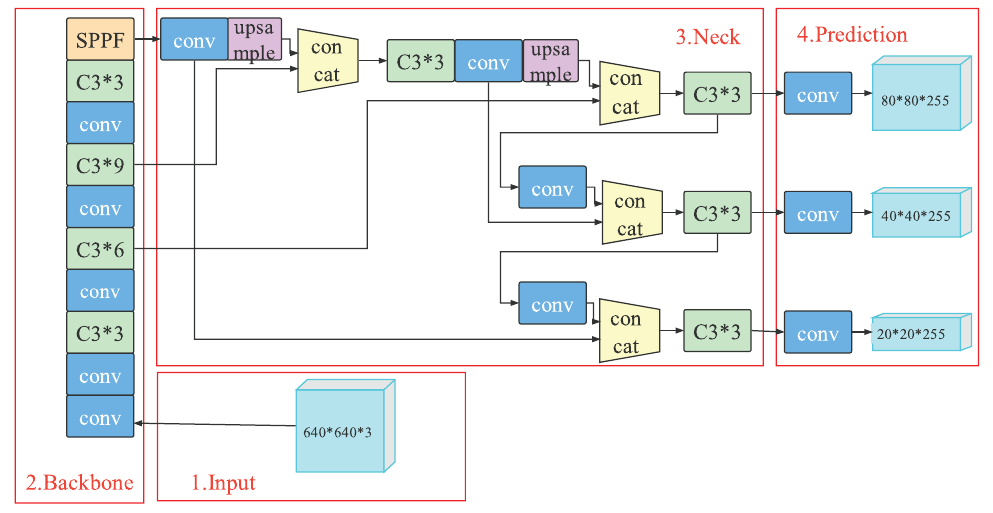
Figure 2. The YOLOv5 network